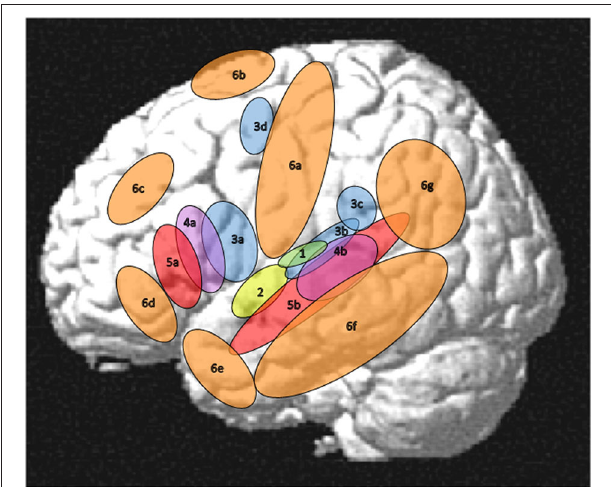
FIGURE 1 | Left-hemisphere schematic display of the auditory cortex (1), the core language network (2–5), and its margins (6). (1) auditory cortex as the primary input structure for verbal communication ( Rauschecker and Scott, 2009 ), (2) auditory word form area as a perceptual core region of the language modality (DeWitt and Rauschecker, 2013; Binder, 2015, 2017), (3) phonological areas linking an auditory-phonetic to an articulatory language code ( Hickok and Poeppel, 2007; Price, 2012; Herman et al., 2013; Binder, 2015; Rogalsky et al., 2015; Battistella et al., 2019 ), (4) syntax processing, manipulating and detecting structures above word level ( Uddén and Bahlmann, 2012; Goucha and Friederici, 2015; Binder, 2017; Regel et al., 2017; Matchin and Hickok, 2019 ), (5) lexical-semantic core areas linking phonological codes to lexical meanings (Price, 2012; Ardila et al., 2016; Binder, 2017; Wilson et al., 2018 ), (6a) Sensorimotor cortex (see section Motor System, Sensorimotor Pathway), (6b) Supplementary motor area (SMA) and pre-SMA (see sections Motor System, Sensorimotor Pathway and Mechanisms of Cognitive Control in the Frontal Lobe), (6c) dorsolateral prefrontal cortex (see section Mechanisms of Cognitive Control in the Frontal Lobe), (6d) orbitofrontal cortex (see section Orbitofrontal Cortex and Emotion Processing), (6e) temporal pole (see section The Temporal Pole and Its Connectivity), (6f) middle and inferior temporal regions (see section Visual Association Areas and Audiovisual Interactions), (6g) parietal and temporoparietal regions (see section Parietal and Inferior and Posterior Temporal Regions). Not shown in this figure, but also relevant for language processing, are right-hemispheric areas (see section Right-Hemisphere Homologues of Left-Dominant Language Areas), subcortical regions including the basal ganglia (see section Basal Ganglia), cerebellum (see section Cerebellum), and thalamus (see section Thalamus), and inner regions of the cortex comprising insula (see section Insula—Interface to the “Inner Being”) and cingulate cortex (see section Mechanisms of Cognitive Control in the Frontal